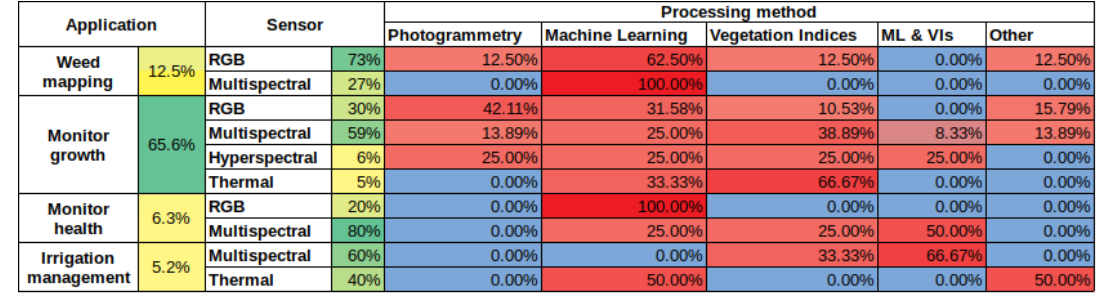
Figure 5. The use of sensors and processing techniques in the different UAVs